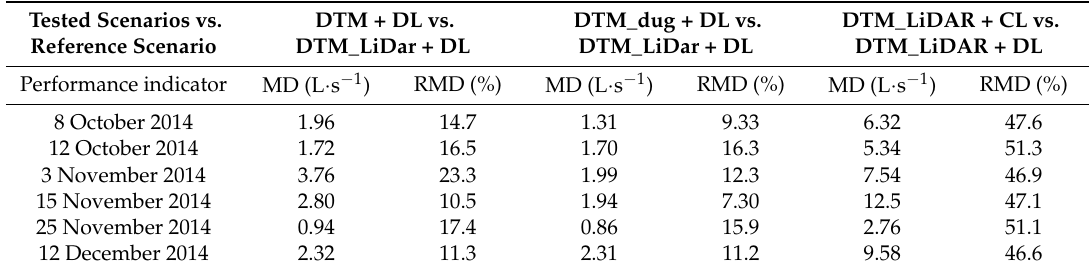
Table 3. Mean deviation ( MD ) and relative mean deviation ( RMD ) between the reference simulations and simulations using low-resolution topographic data and coarse land-use information, respectively. Tested Scenarios